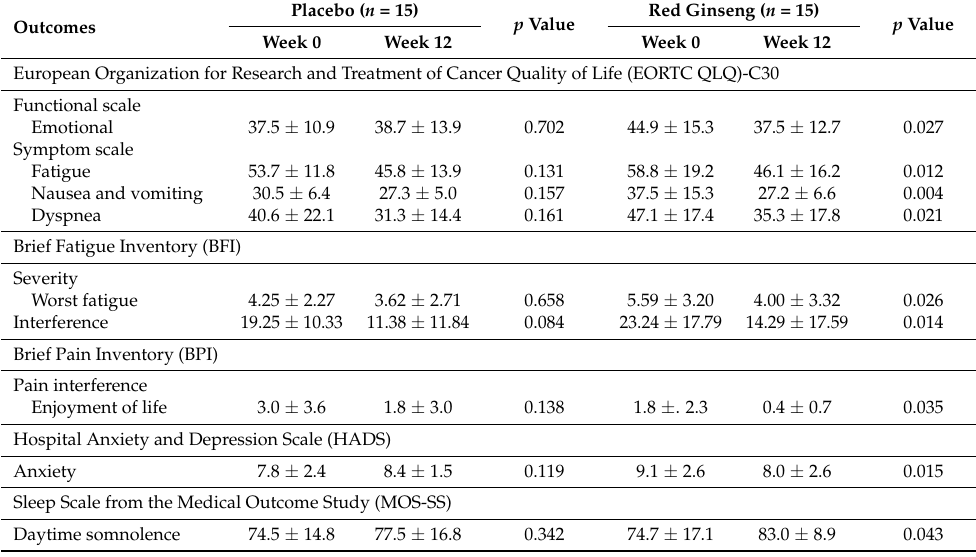
Table 4. Evaluation of the effect of red ginseng on health-related quality of life.